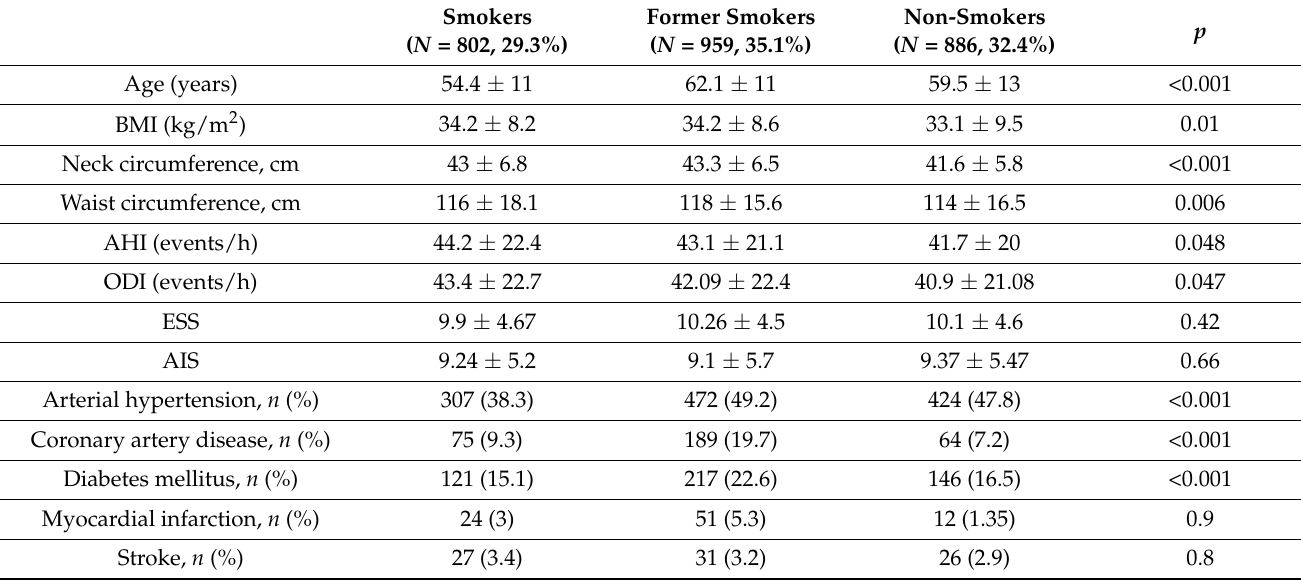
Table 3. Characteristics of the participants with OSA according to their smoking habits.